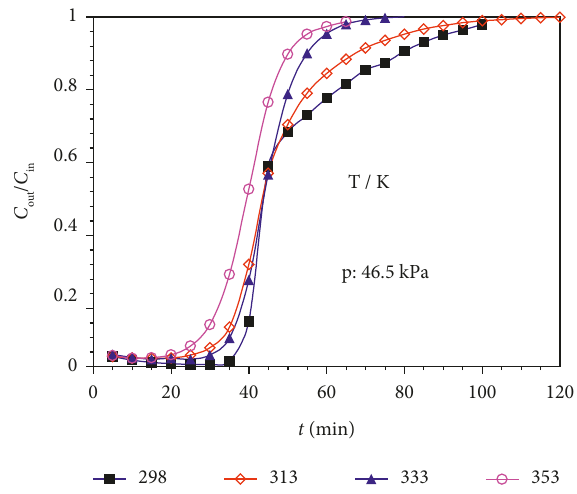
Figure 2: CO 2 absorption curves of MEA with 20wt.%.